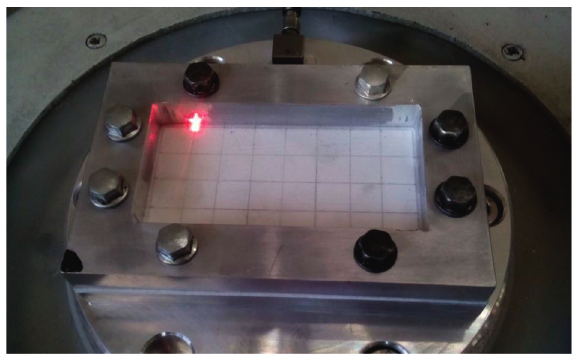
Figure 10: Specimen for experimental modal analysis (Case 2).